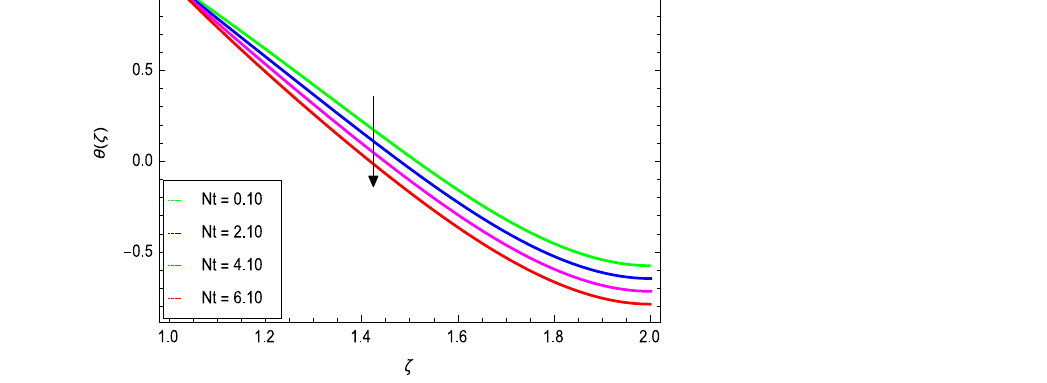
Figure 11. θ (ζ) as a function of Nt .